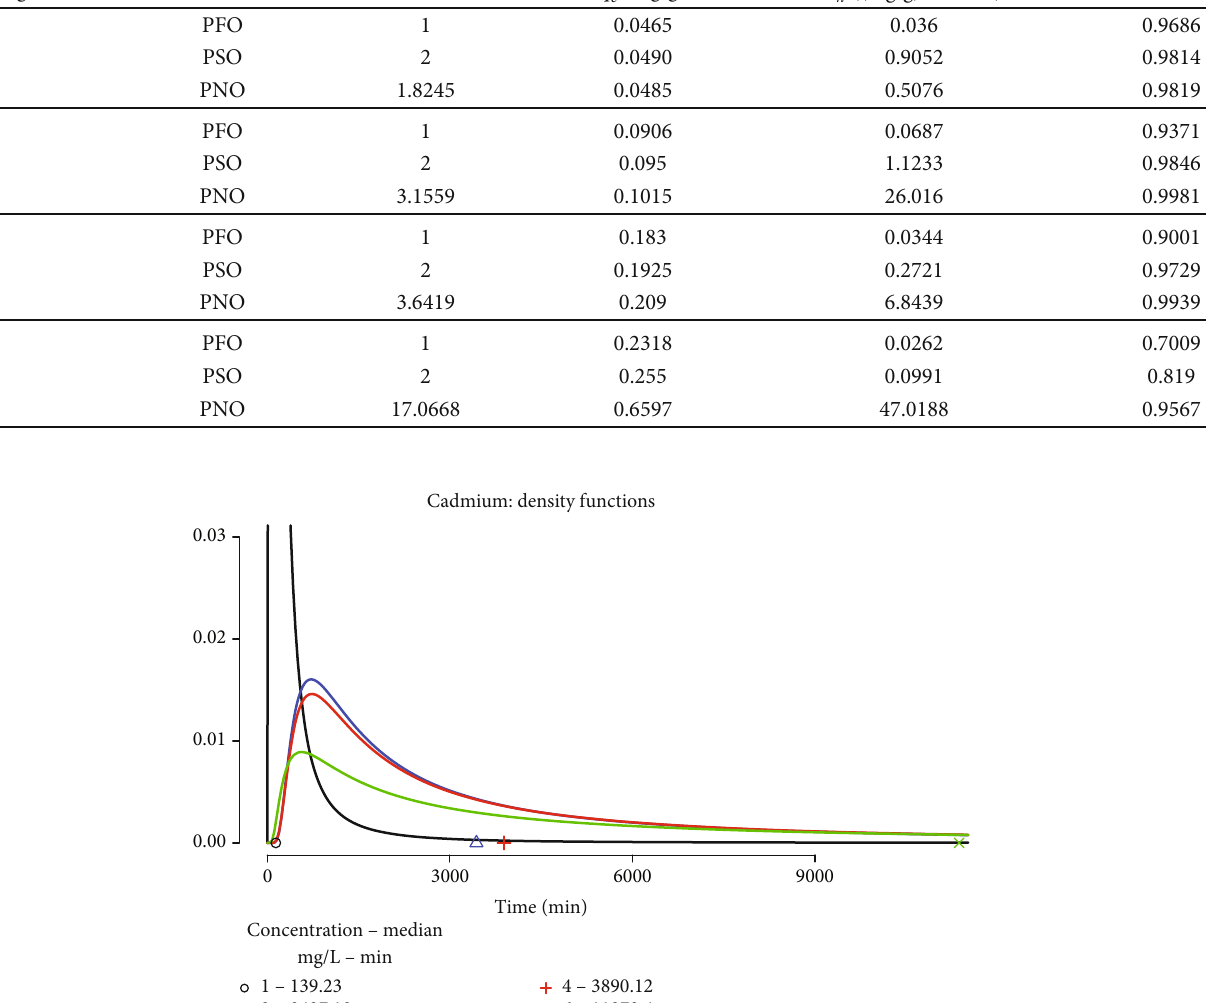
) needed to reach equilibrium for the removal of Cd(II) using reed leaves at initial Cd(II) e